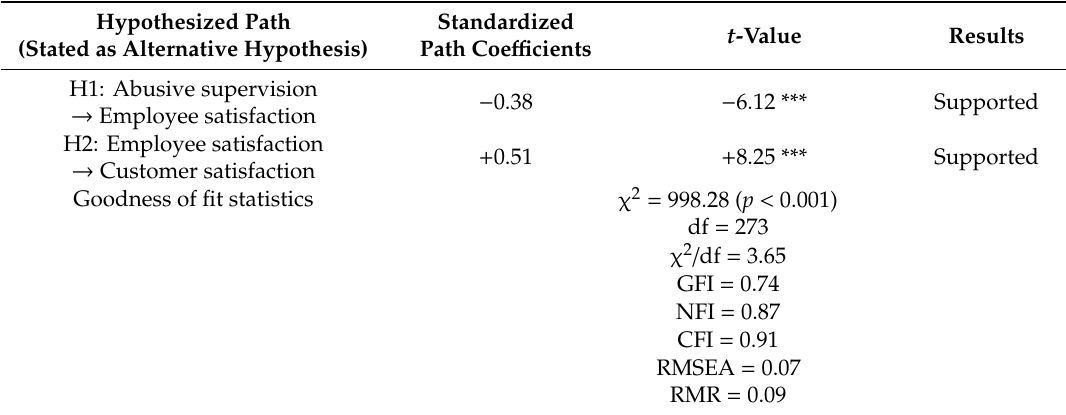
Table 4. Structural parameter